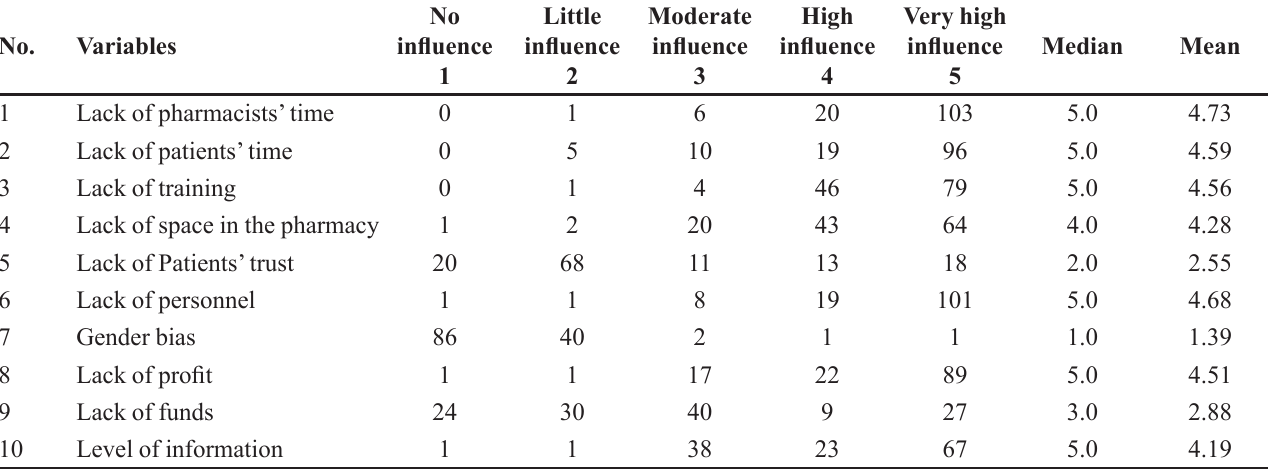
TABLE IV - Influence of the under-listed variables on community pharmacists’ participation in public health activities